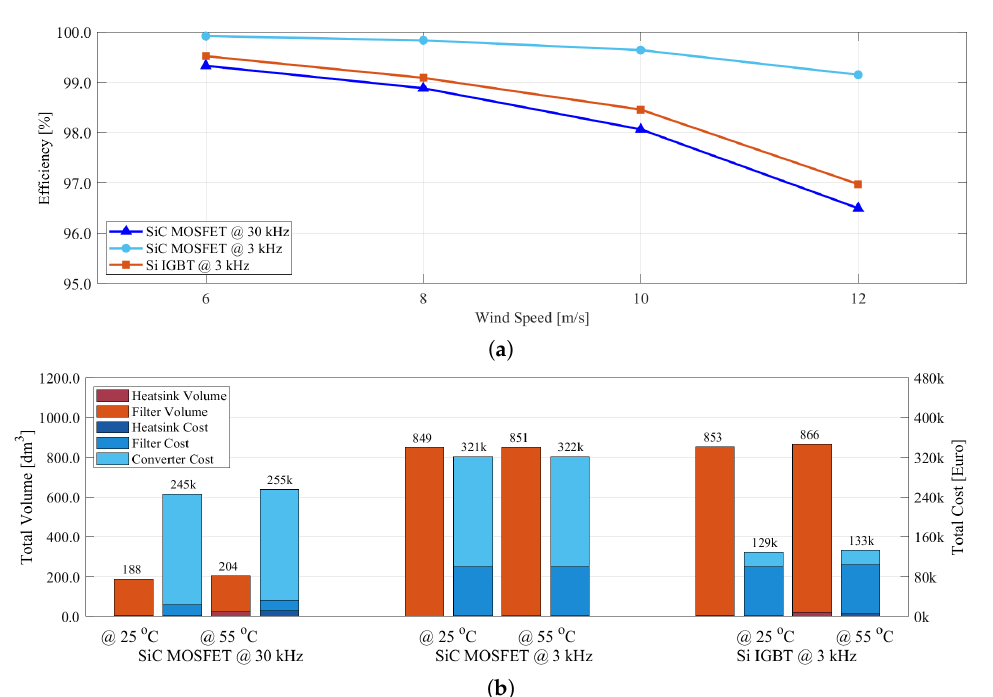
Figure 6. Comparison of SiC-MOSFET- and Si-IGBT-based converters for different wind speeds and 30 kHz and 3 kHz switching frequencies: ( a ) efficiency, ( b ) cost and